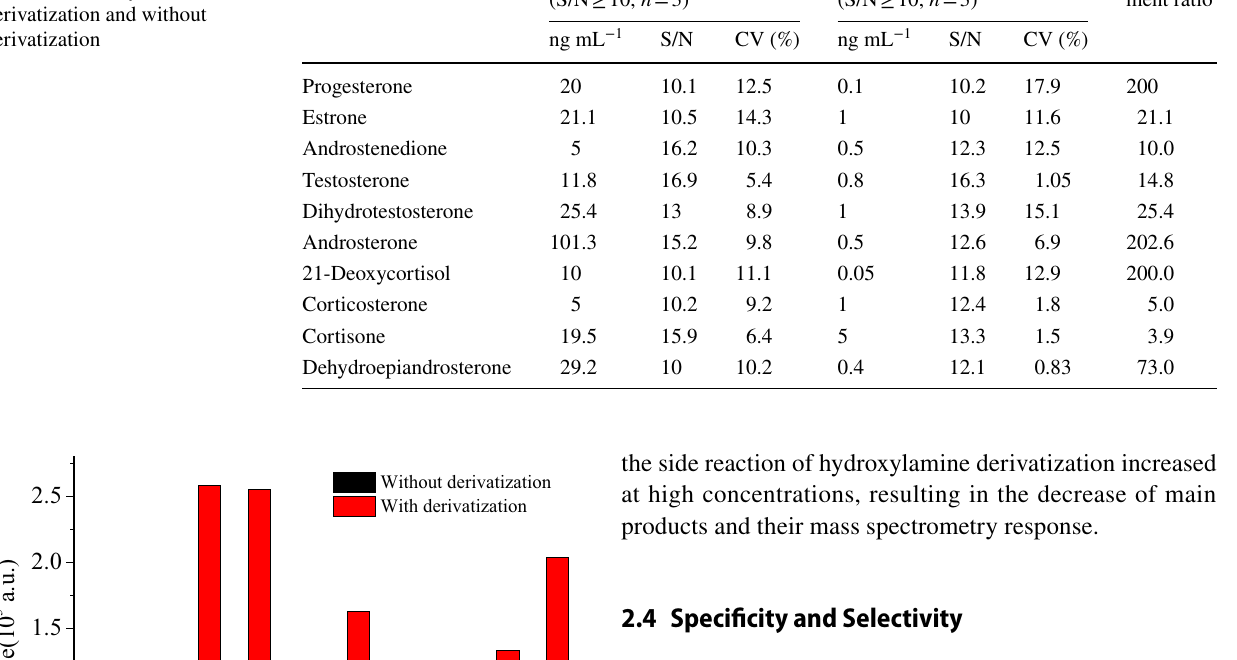
Table 1 Comparison the LOQ for the analysis with derivatization and without derivatization